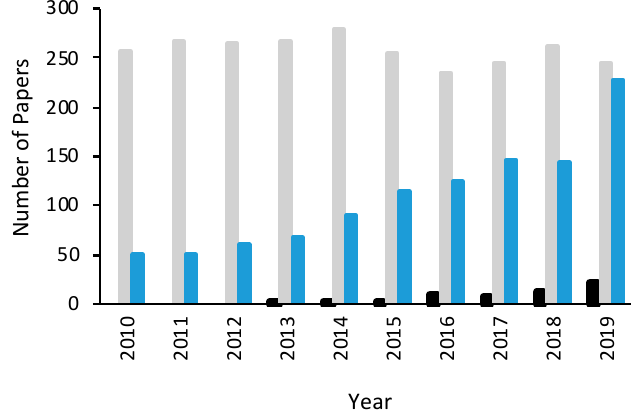
Figure 2. Number of publications shown as a function of the year of publication, taken from Scopus, for Fenton (grey), E-Fenton (blue) and E-Fenton coupled with graphene-based materials (black).